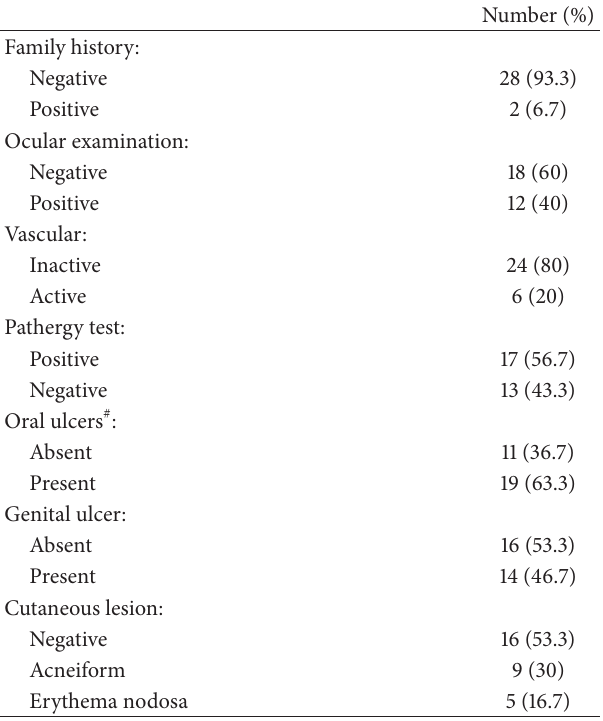
Table 1: Frequency distribution of clinical data of patients included in the